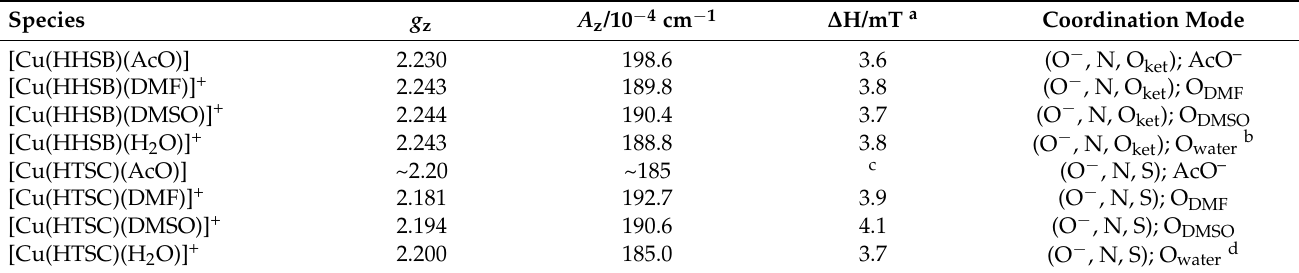
a Linewidth of the low-field parallel hyperfine resonance. b Parameters taken from ref. [26]. c Value not measurable. d Parameters taken from ref. [40]. EPR spectrum recorded at 120 K on the polycrystalline powder of {[Cu(HIN)](AcO)} were characterized by two g values in the order g z > g x ~ g y > g e (trace a of Figure 3). These values are consistent with a d x2–y2 ground state and a square planar geometry [41,42]. As pointed out recently in the literature, the broad signal is due to a mixture of intercenter exchange and dipolar interactions [43]. Interestingly, when the solid compound is dissolved in on organic solvent such as DMF or DMSO, the spectra do not change and the hyperfine coupling with copper nuclei, typical of solution spectra, is not resolved. The values of g z and g y ~g x remain almost unchanged and in DMSO solution they can be measured with accuracy (Table 2). This indicates that the structure in the solid state is retained and that the copper ions continue to interact magnetically. These findings can be explained postulating the formation of a polymeric structure with the pyridine-N binding Cu(II) ion of another unit and bridging two different copper centres in the axial position, the equatorial sites being occupied by three HIN donors and acetate ion, as demonstrated by IR spectroscopy (Figure 4). As pointed out recently in the literature, this is possible for Cu(II) complexes [44]. Therefore, the correct formulation of the complex formed by HIN may be {[Cu(HIN)](AcO)} n to indicate its polynuclear